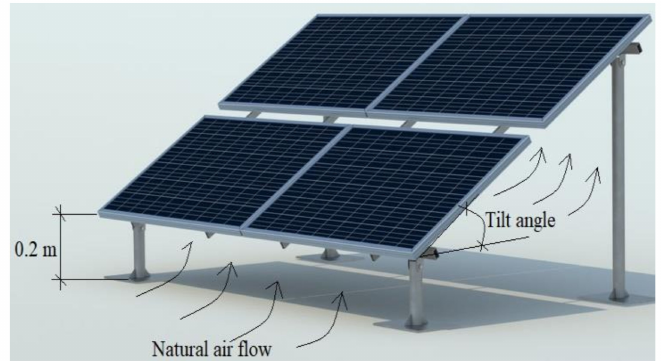
Figure 15. PV module mounting gap representation. Courtesy of https://grabcad.com/library/ solar-panel-mounting-structure-2 (accessed on 12 May 2021)